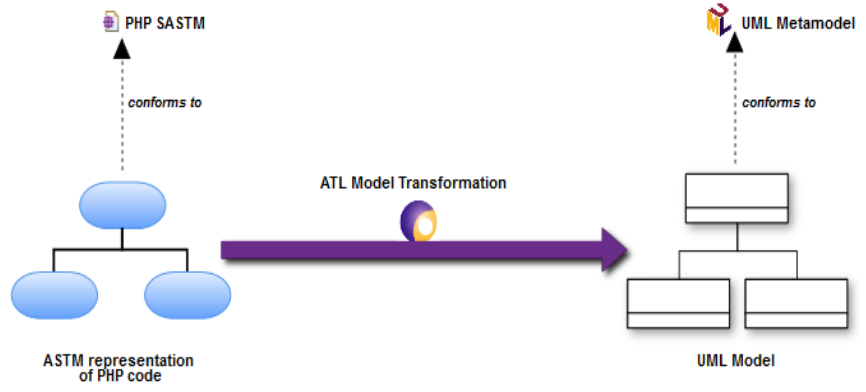
Fig. 3. Description of the model transformation